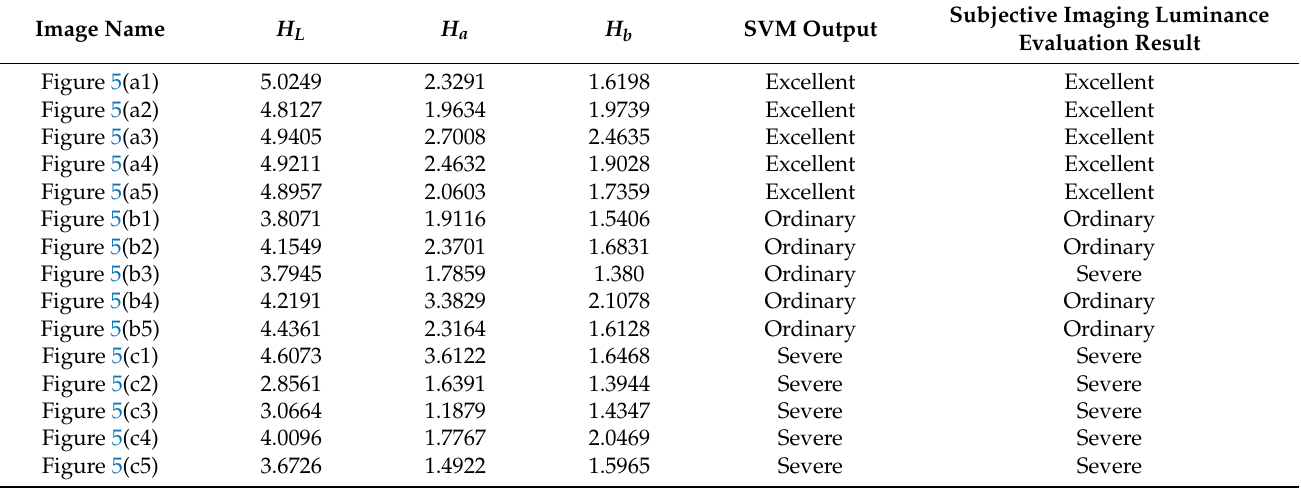
Table 4. Results of information entropy indices, SVM output, and subjective imaging luminance evaluation.